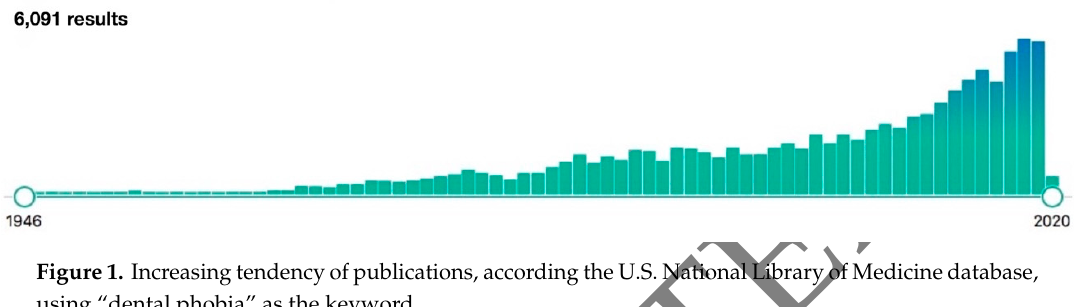
Figure 1. Increasing tendency of publications, according the U.S. National Library of Medicine database, using “dental phobia” as the keyword.